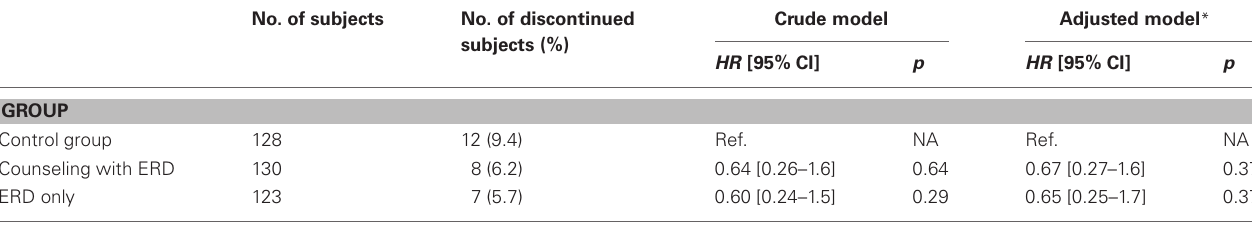
Table 3 | The effectiveness of the interventions on proportion of patients that discontinued therapy over time assessed using Cox proportional hazards.